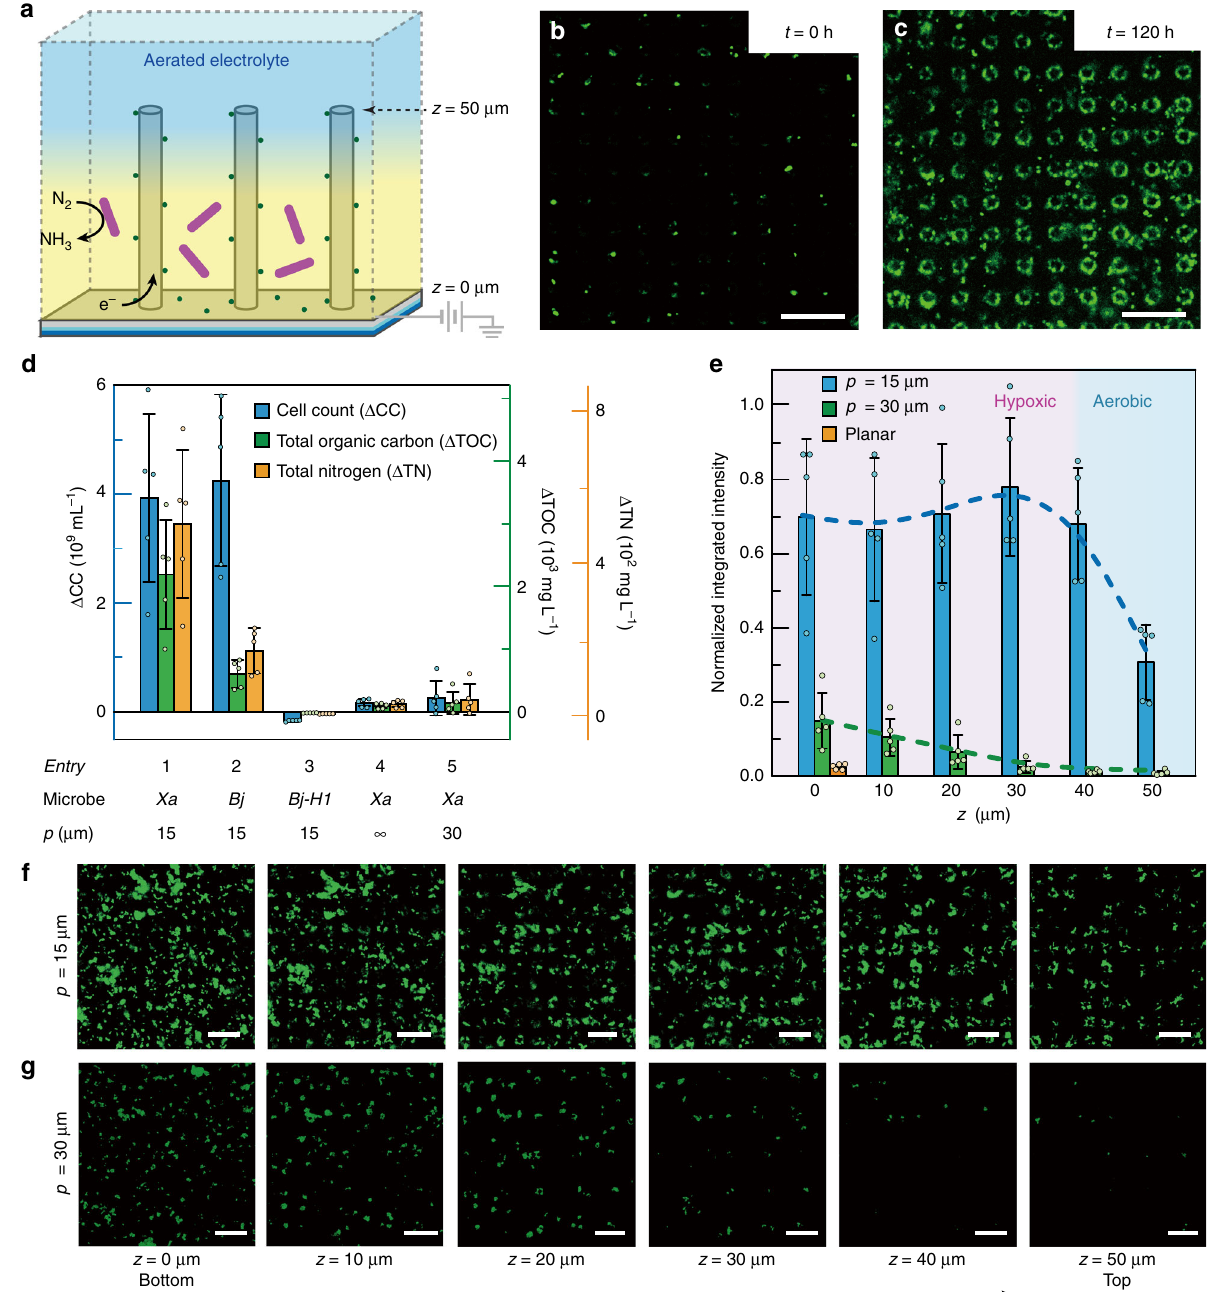
Fig. 3 Electricity-driven N 2 fi xation in air. a Schematic illustration of the functional device. b , c Fluorescent images of B. japonicum , indicative of biomass accumulation, before b and after c 120-h operation in microwire array. E appl = − 0.15 V vs. RHE, p = 15 µ m, images taken at z = 20 μ m. d Changes of cell count ( Δ CC), as well as the retained total nitrogen ( Δ TN) and total organic carbon ( Δ TOC) in biomass in the device, calculated as the differences between values before and after 120-h operation with the provision of electricity ( n = 5). ∞ , planar electrode; Xa X. autotrophicus ; Bj B. japonicum, Bj-H1 B. japniucum-H1 , a B. japonicum variant with disrupted nifH gene. e Integrated fl uorescent intensities of X. autotrophicus , indicative of biomass accumulation, at different z positions for different electrode morphologies. The hypoxic (pink) and aerobic (blue) domains for wire array of p = 15 µ m are suggested ( n = 5). f , g Series of x – y cross-sectional fl uorescent images at different z planes for X. autotrophicus population within wire arrays of p = 15 μ m f and p = 30 μ m g . Pseudo-colored in green. Scale bars, 30 μ m. The setup for imaging is mounted on an inverted microscope so the wire array is facing down during observation (as shown in Supplementary Fig. 4). For panels d and e , dot-plot of individual measurements is overlaid with the bar graph. Error bars = standard deviation ( n =